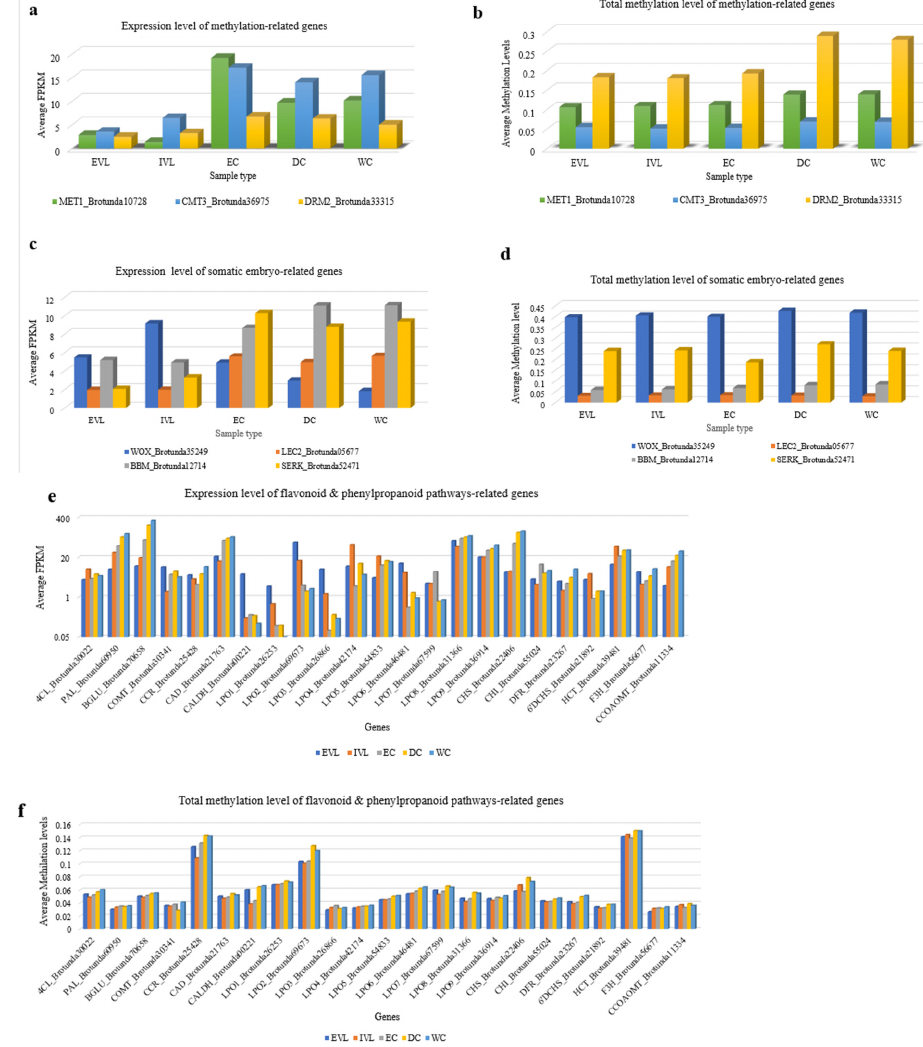
Figure 7. Expression level and total methylation level in all cytosine contexts of methylation-related genes ( a , b ), somatic embryogenesis-related gene ( c , d ) and flavonoid and phenylpropanoid biosyn- thesis pathways-related genes ( e , f ) in ex vitro leaf (EVL), in vitro leaf (IVL), embryogenic callus (EC), dry callus (DC), and watery callus (WC). CAD, cinnamyl alcohol dehydrogenase; BGLU, Beta- glucosidase; CALDH, coniferyl-aldehyde dehydrogenase; C4H, cinnamic acid 4-hydroxylase; 4CL, 4-coumarate–CoA ligase; CHS, chalcone synthase; CHI, chalcone isomerase; CCoAOMT, caffeoyl- CoA 3-O-methyltransferase; C3H, ρ -coumarate 3-hydroxylase; CCR, cinnamoyl-CoA reductase; COMT, caffeic acid O-methyltransferase; 6’DCHS, 6 ′ -deoxychalcone synthase; DFR, dihydroflavo- nol 4-reductase; F3H, flavonoid 3-hydroxylase; F5H, ferulate 5-hydroxylase; HCT, Hy- droxycinnamoyl-CoA shikimate; LPO, Lactoperoxidase; PAL, phenylalanine ammonia lyase.